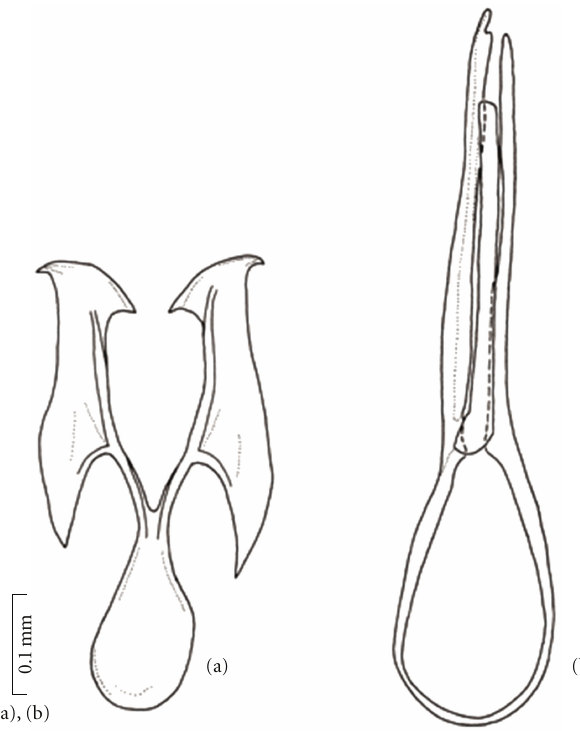
Figure 6: Hydrocyphon sagittiger sp.n., holotype, male. (a) Tegmen; (b)